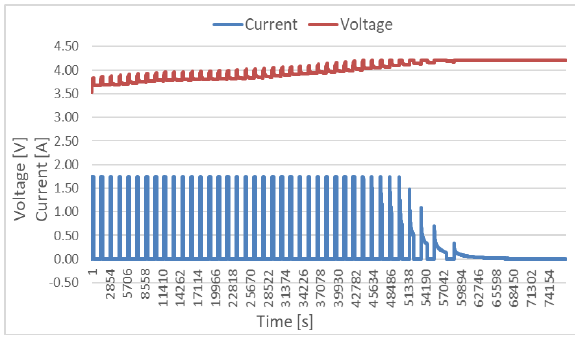
Figure A5. Experimental Voltage & Current waveforms.